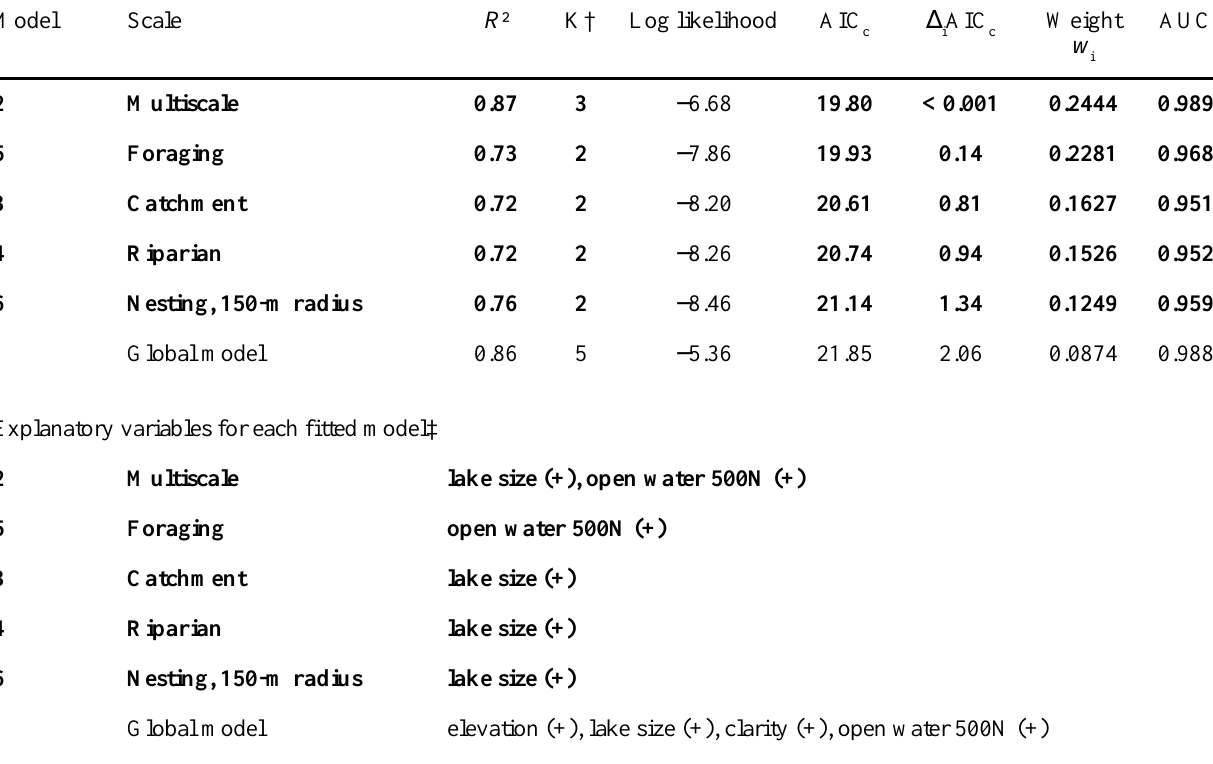
Table 4. Summary of results for ecoregion 1 (Northern White Mountain) habitat models with their associated Akaike weights. N = 59 lakes. Models with empirical support, i.e., D iAIC Model